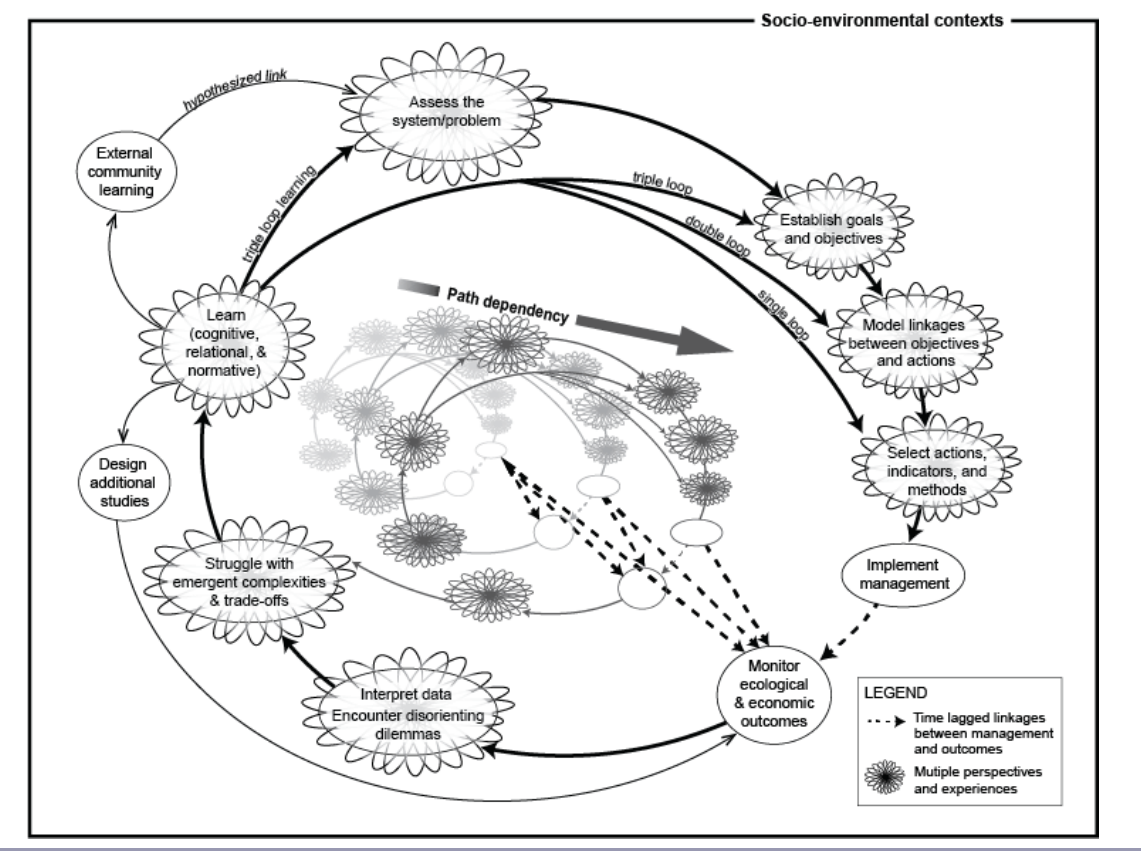
Fig. 9 . Revised conception of collaborative adaptive management (CAM) based on the collaborative adaptive rangeland management (CARM)